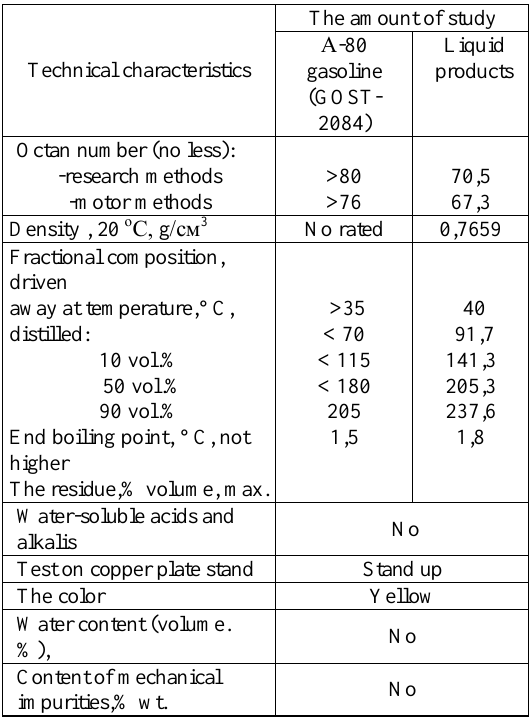
Table 7. Technical characteristic of the gasoline fraction (b,p-200 O C) of the liquid product after heat treatment